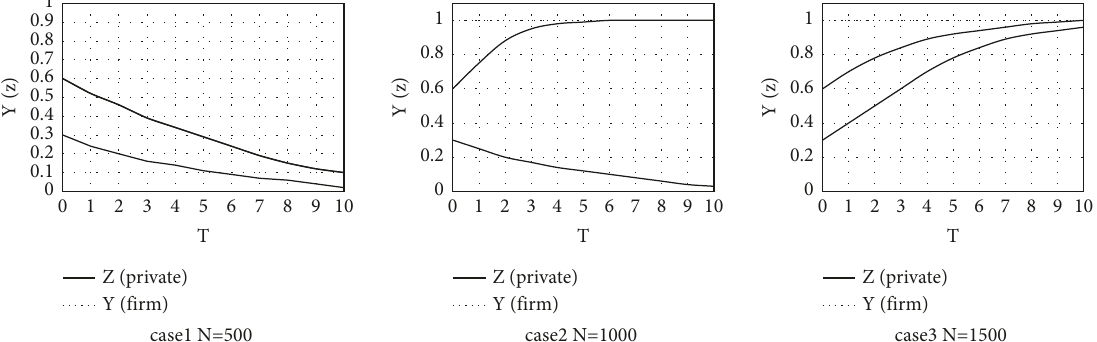
Figure 3: N impact of changes on the evolution of co-created value.